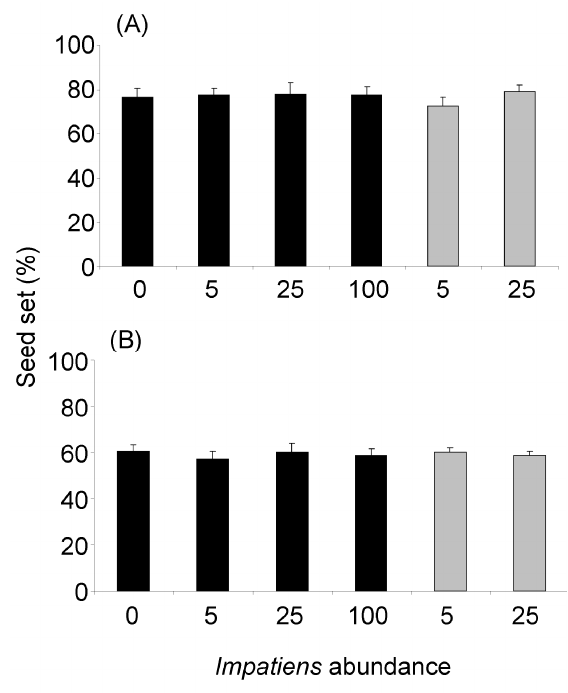
F IG . 6. Seed set of (A) A. napellus and (B) E. angustifolium for both years and sites pooled, according to the abundance (0, 5, 25 and 100 individuals) and proximity (black bars: 0 m distance, grey bars: 15 m distance) of the